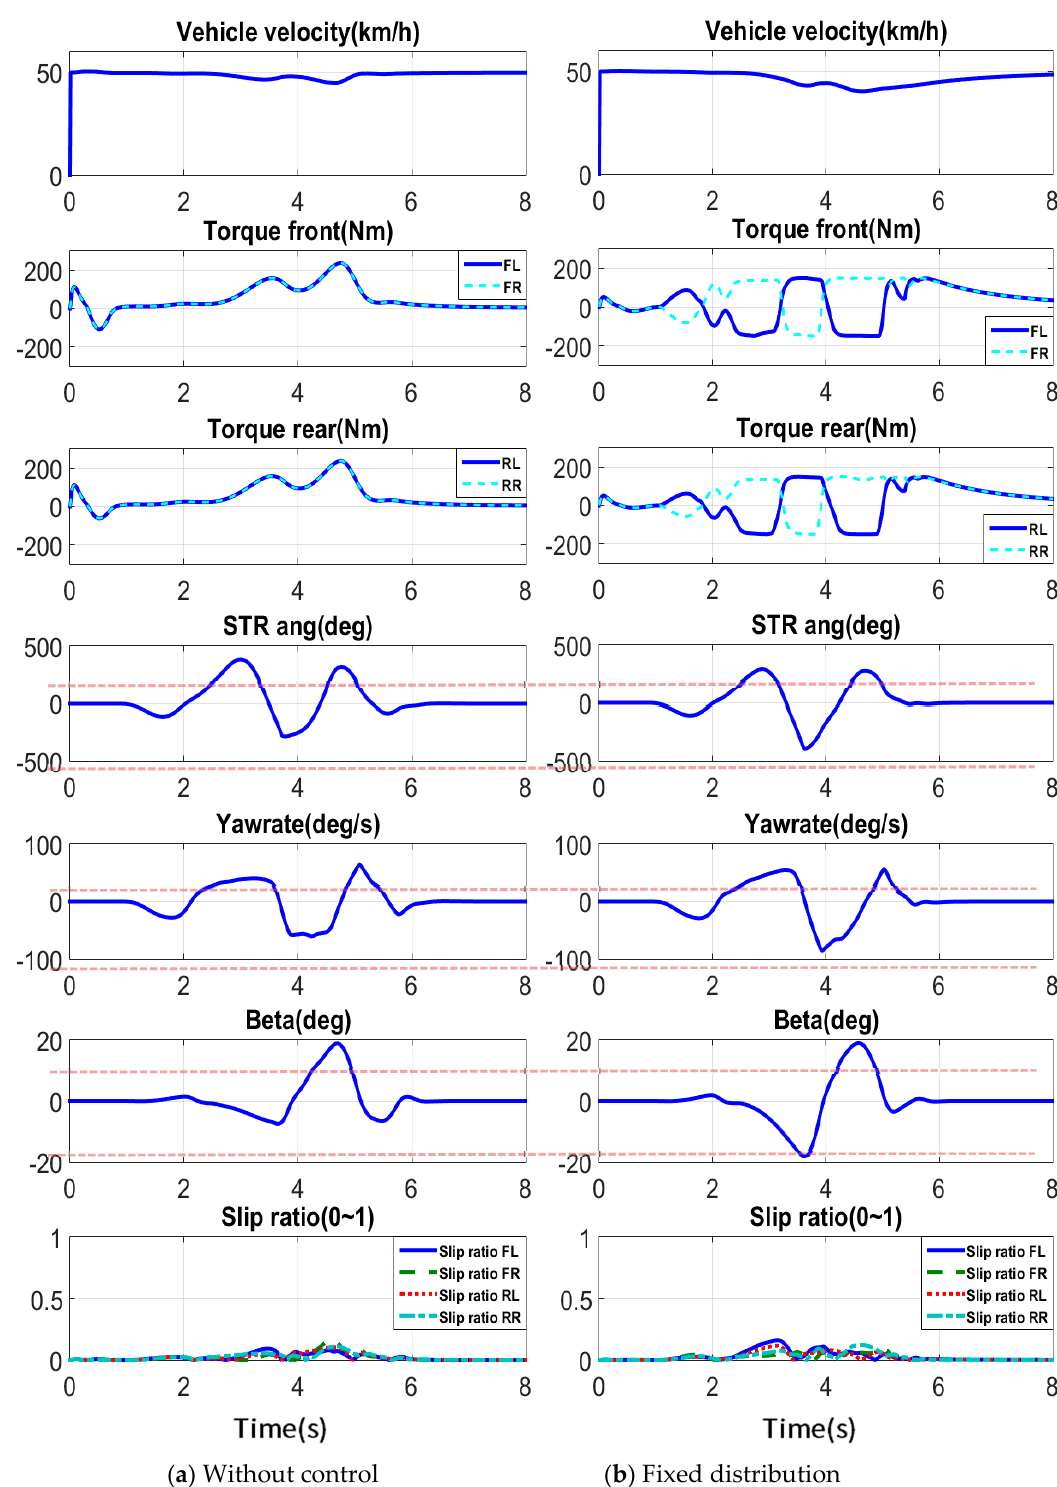
Figure 10. Simulation results of short double-lane change (No control, Fixed distribution).